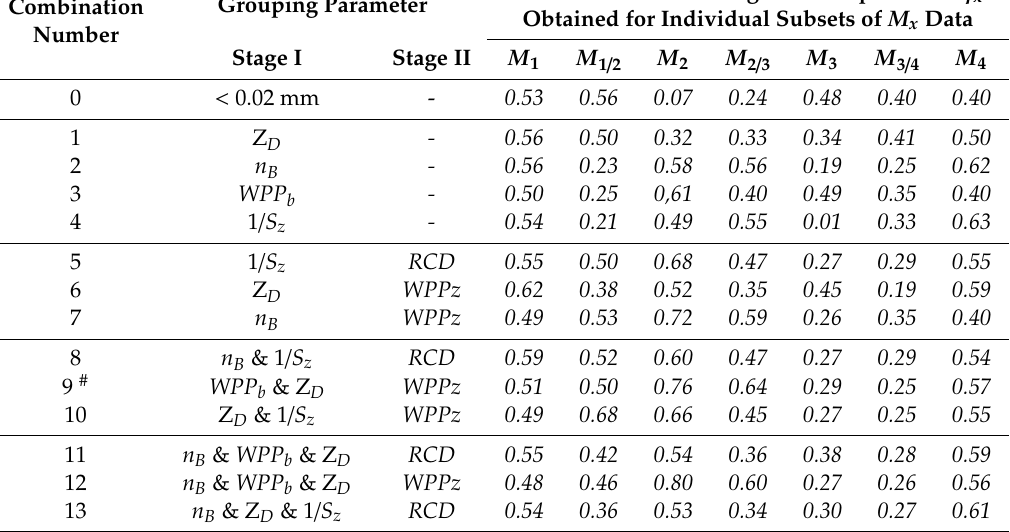
Table 5. Determination factor values ( R 2 ) for particular subsets ( M x ) and selected “best” data grouping combinations obtained for dependency of penetration resistance ( PR ) on moisture gravimetric content and dry bulk